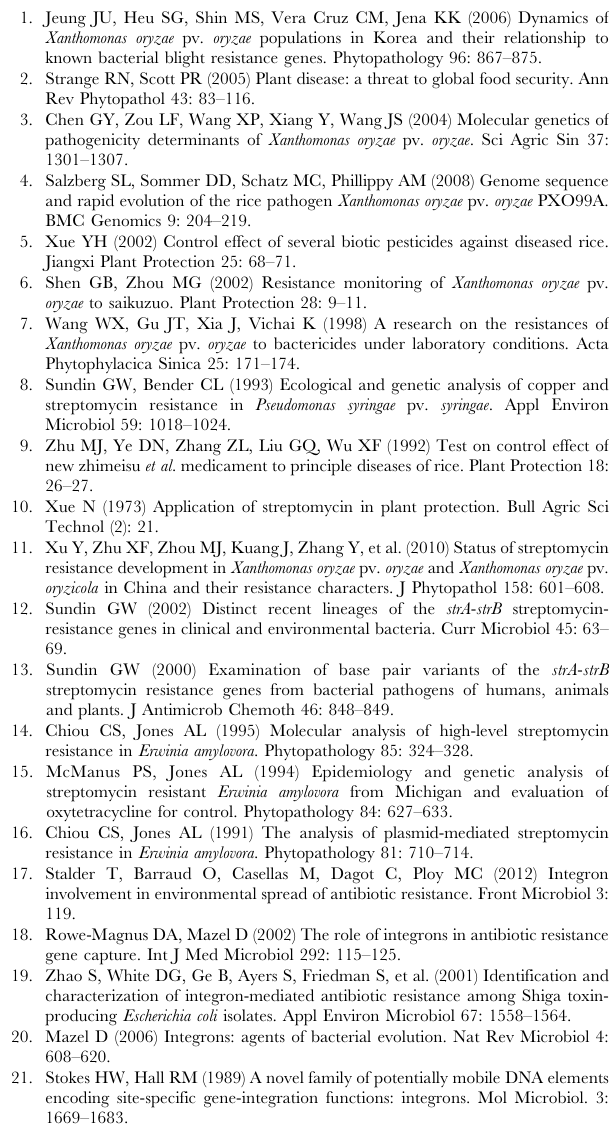
Figure S1 PCR confirmation of recombinant plasmids from transformants. M, DL2000 Marker; lane 1–4, plasmid pUFR034, amplified by primer pairs aac6f/aac6r, arr3/arr3r, aadaf/aadar, and integronf/integronr, respectively; lane 5, plasmid from PXO1-1, amplified by aac6f and aac6r; lane 6, plasmid from PXO2-1, amplified by arr3f and arr3r; lane 7, plasmid from PXO3-1, amplified by aadaf and aadar; lane 8, plasmid from PXO4-1, amplified by integronf and integronr. Table S1 Primer pairs used in this study.